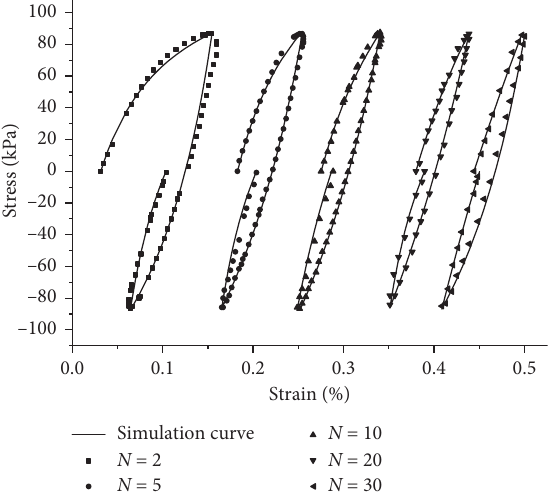
Figure 13: Test data and simulation curves corresponding to a cyclic